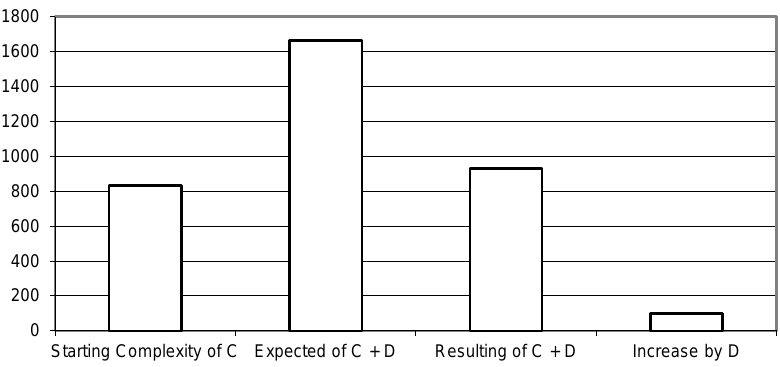
Figure 3. Organization structure complexity of the SAP system in Enterprises C and